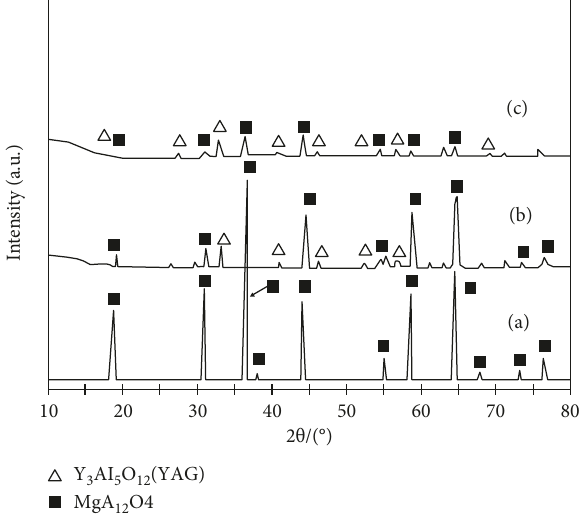
Figure 1: XRD diagram of magnesium aluminate transparent ceramic (a) and magnesium aluminate fluorescent transparent ceramic